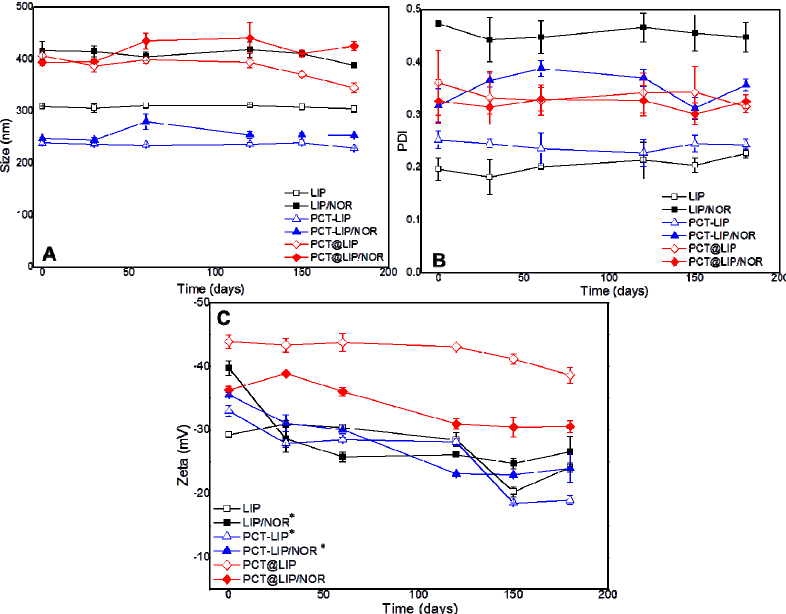
Figure 1. Stability study of the formulations with and without 0.2% NOR ( w / v ) in terms of size ( A ), PDI ( B ), and zeta potential ( C ) during 6 months of storage at 4 ◦ C, n = 3. Statistical methods ANOVA / Tukey were used; * = p <